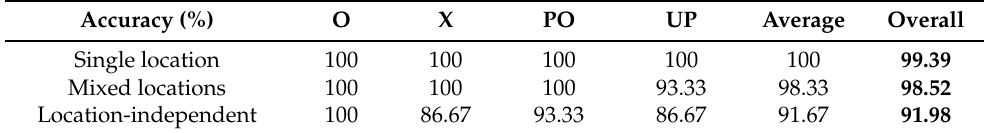
Table 3. The recognition accuracy of different activities.